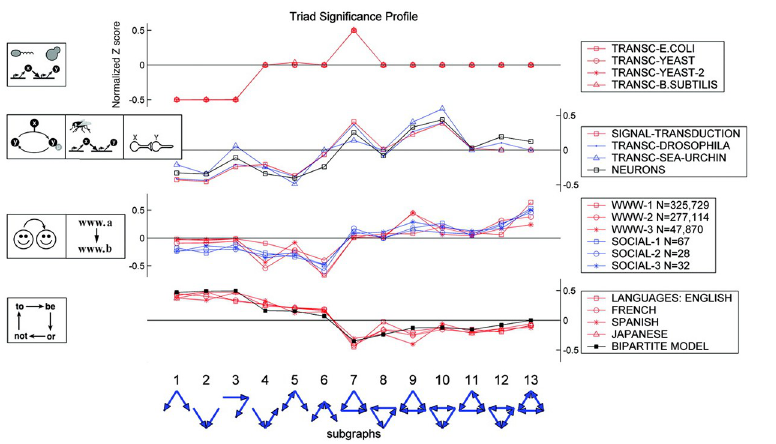
Fig 3. Motif distribution examples detected in various fields of network [23].